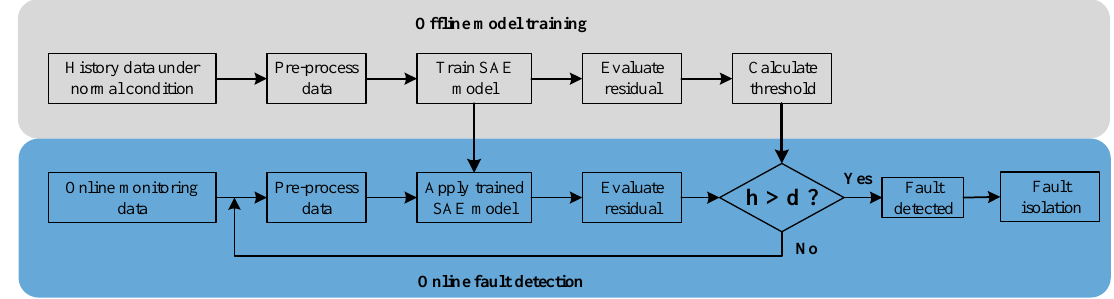
Figure 1. Diagram of proposed fault detection and isolation scheme.